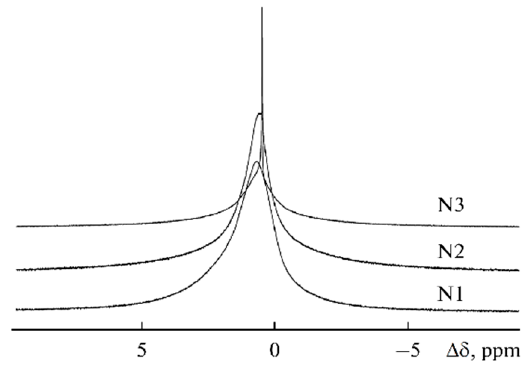
Figure 23. 7 Li NMR spectra of samples 1–3 [58].